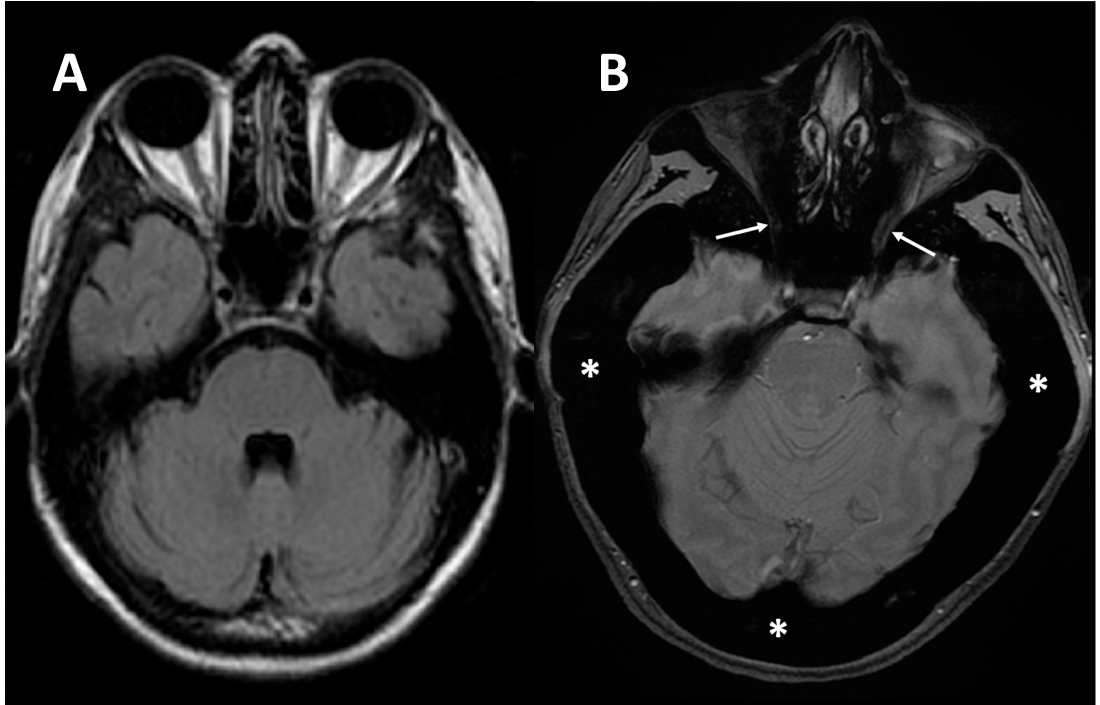
Figure 6. ( A ) axial MRI of a healthy young female (shown as comparison). ( B ) axial MRI (T2w*) of a 38-year-old female with a clinical-radiological diagnosis of osteopetrosis (ARO type); narrowing of both optic foramens can be noted (arrows) caused by a diffuse bone thickening. Diffuse bone thickening of cranial bones is associated with a marked ipointense signal intensity of all the skeletal structures related to the diffuse bone sclerosis (asterisks).